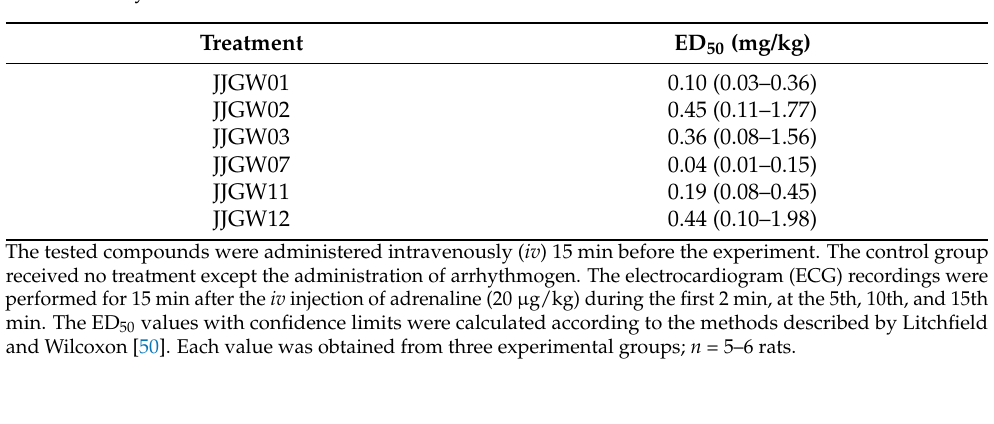
Table 3. The prophylactic antiarrhythmic activity of arylpiperazine derivatives in the adrenaline- induced arrhythmia model in